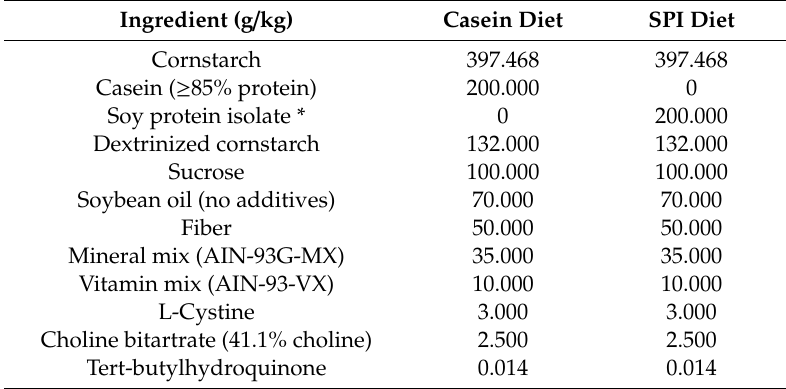
Table 2. Composition of AIN-93G-based casein and soy protein isolate (SPI)